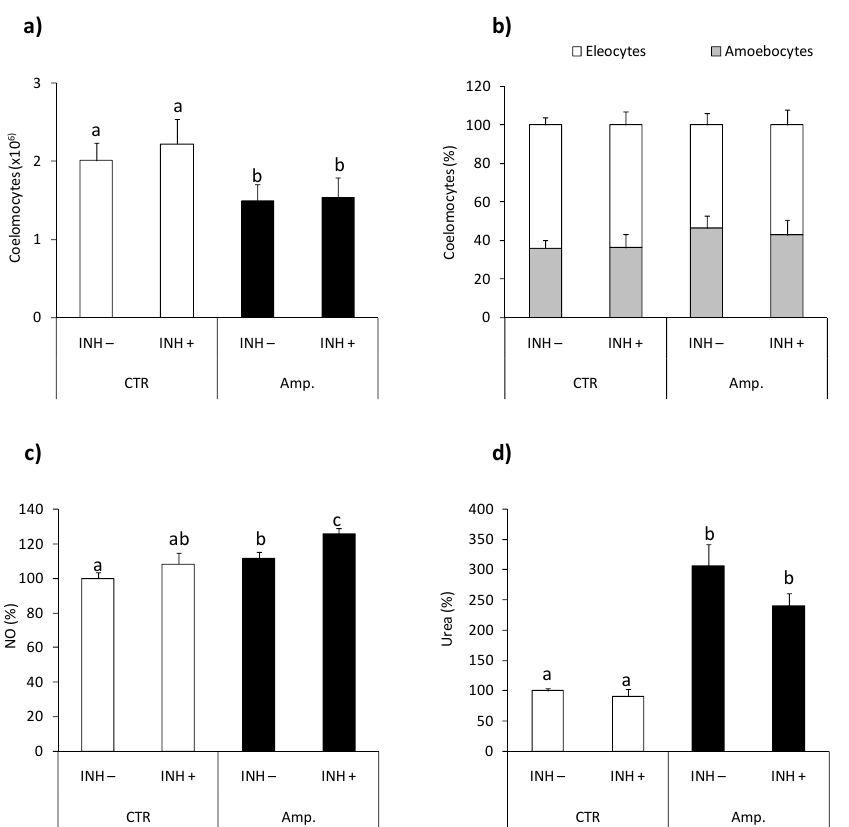
Figure 6. Effects of segment amputation on arginase activity and nitric oxide production in Eisenia andrei coelomocytes. Coelomocytes were collected from control animals (CTR) or from animals 72 h post-amputation of 5 posterior segments (Amp.). Earthworms were injected for 1 h with arginase inhibitor L -norvaline (100 mM, INH+) or with 0.9%NaCl (INH–). The number ( a ) and composition ( b ) of coelomocytes were counted. Nitric oxide (NO) production ( c ) and arginase activity ( d ) are showed as % of control (NO production and arginase activity in coelomocytes of CTR animals = 100%). Mean values that are significantly different are not assigned a common letter (e.g., a vs. b or b vs. c) according to one-way analysis of variance (ANOVA) (at p < 0.05).